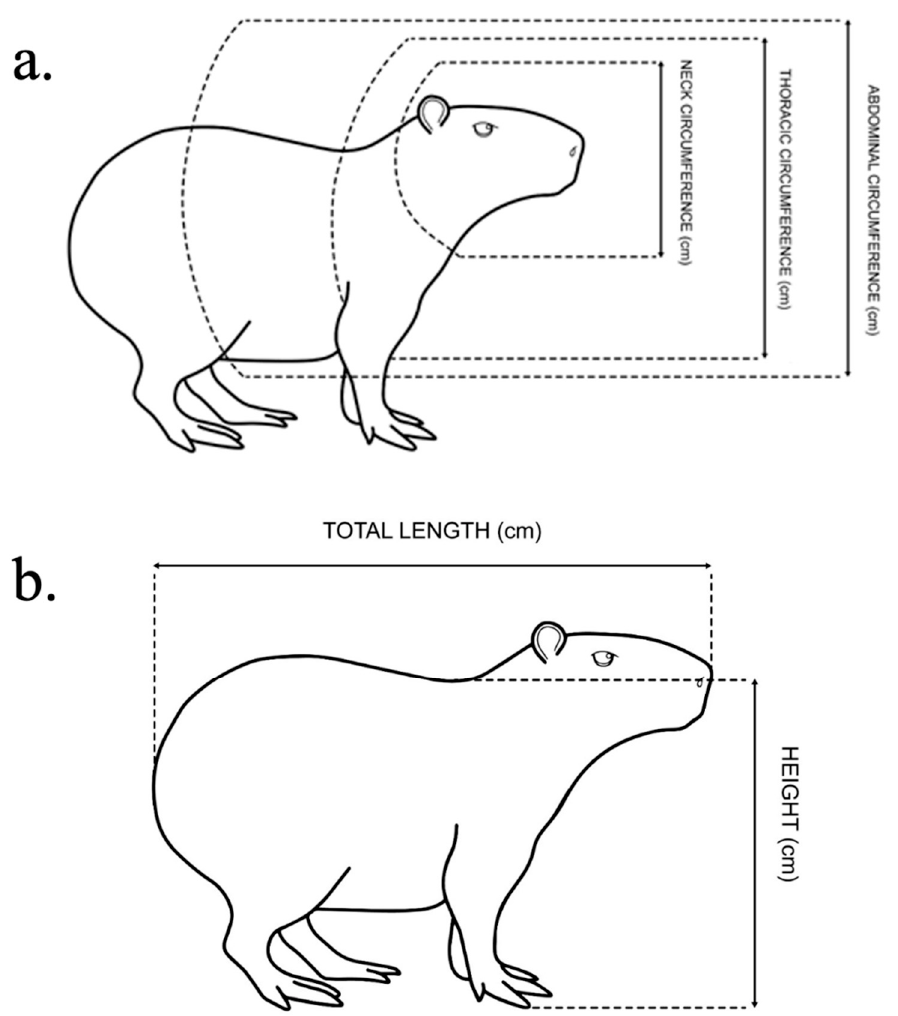
Figure 1. Representation of the measures taken from the capybaras. Linear measurements ( a ), and circumference measurements ( b ). circumference measurements ( b